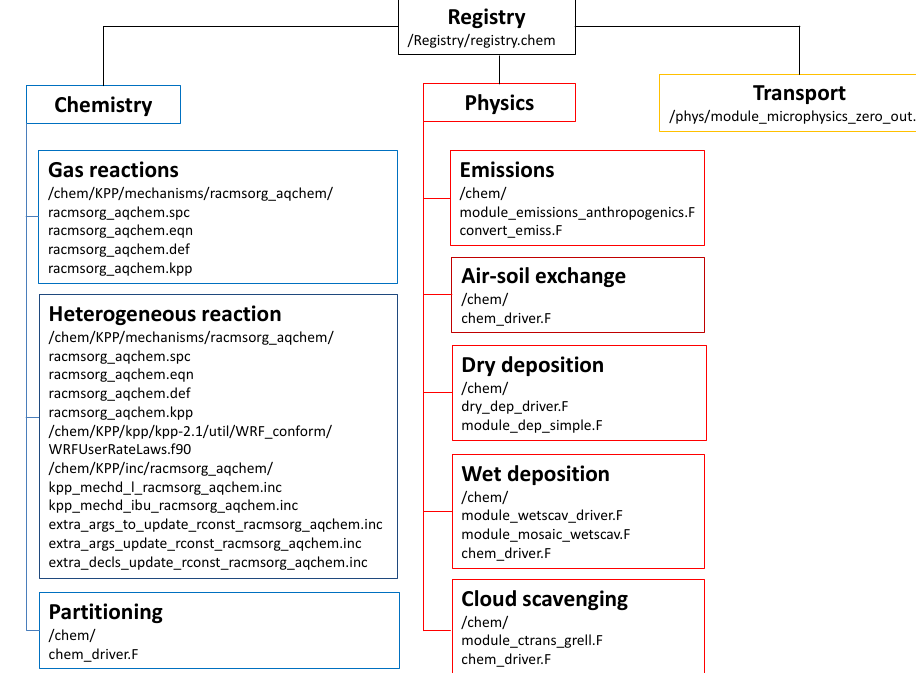
Figure 1. Framework of PAH extensions in